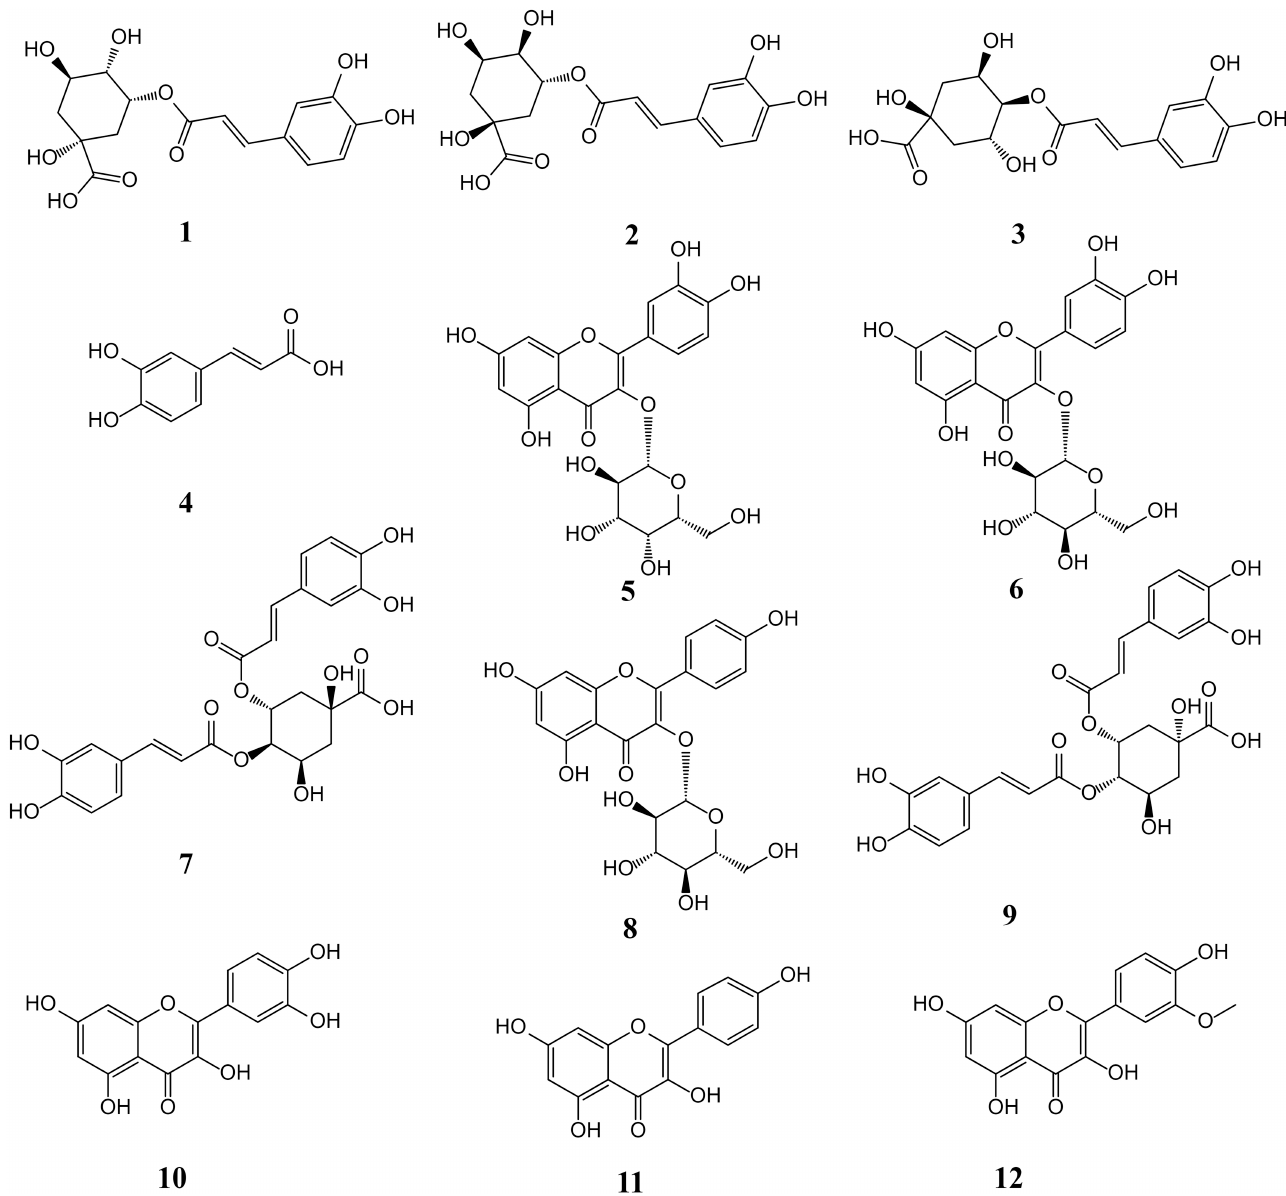
Figure 1. Structures of the bioactive components 1 – 12 in Cuscutae Semen. 1 , neochlorogenic acid; 2 , chlorogenic acid; 3 , cryptochlorogenic acid; 4 , caffeic acid; 5 , hyperoside; 6 , isoquercitrin; 7 , isochlorogenic acid B; 8 , astragalin; 9 , isochlorogenic acid C; 10 , quercetin; 11 , kaempferol; 12 , isorham- netin.